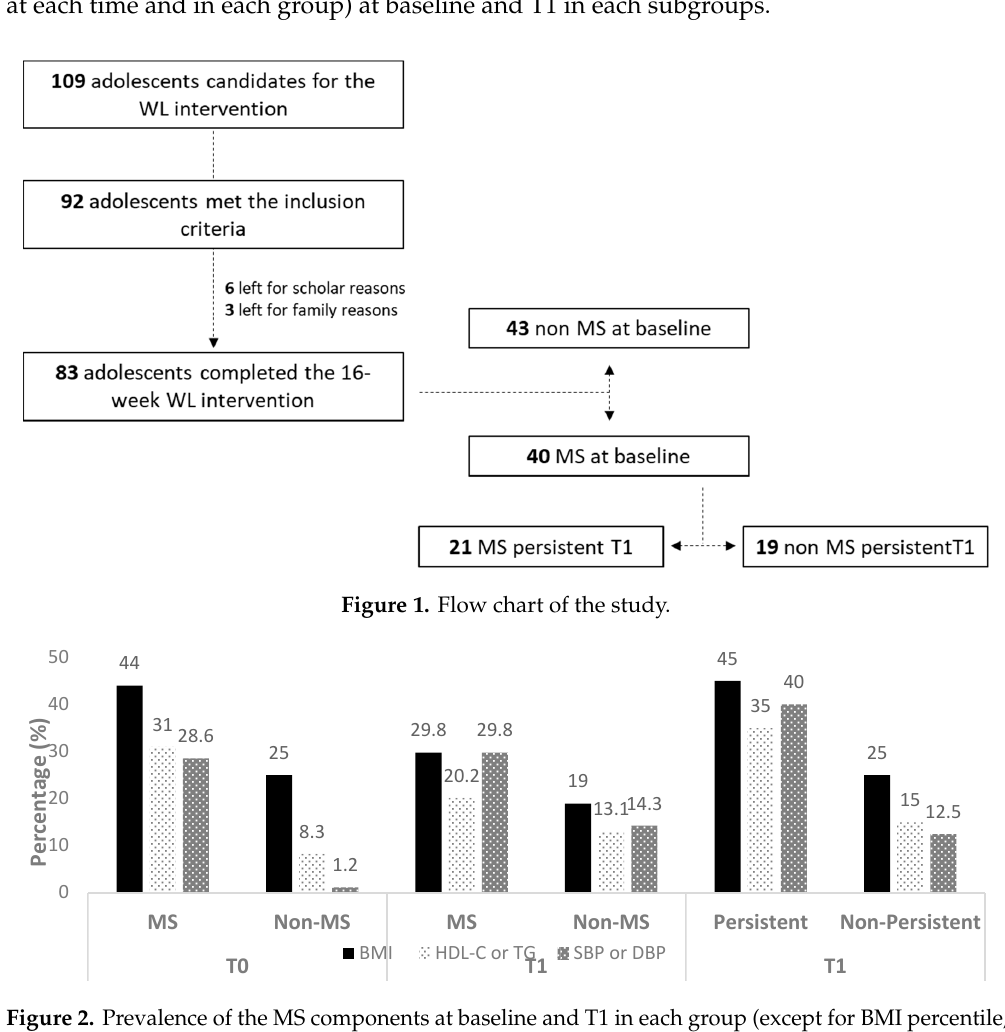
Figure 2. Prevalence of the MS components at baseline and T1 in each group (except for BMI percentile, which remained present in all the adolescents at both times). MS: adolescents with metabolic syndrome; non ‐ MS: adolescents without metabolic syndrome; BMI: body mass index; HDL ‐ C: high density lipoproteins cholesterol; TG: triglycerides; DBP: diastolic blood pressure; SBP: systolic blood pressure; HOMA ‐ IR: homeostatic assessment model for insulin resistance; T0: baseline;